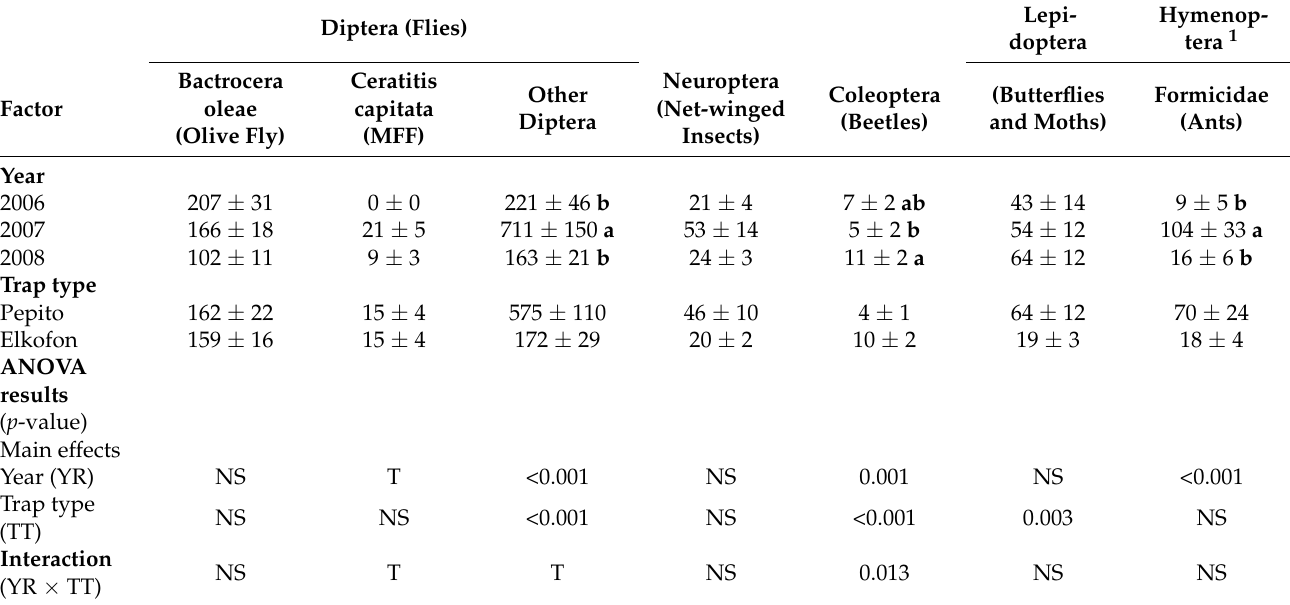
Table 3. Effect of, and interactions between, (a) year (2007 or 2008), (b) plastic bottle-based mass- trapping system (Pepito or Elkofon) on the mean number of invertebrates belonging to different orders (common names) caught in bottle traps positioned in table olive cv Kalamon